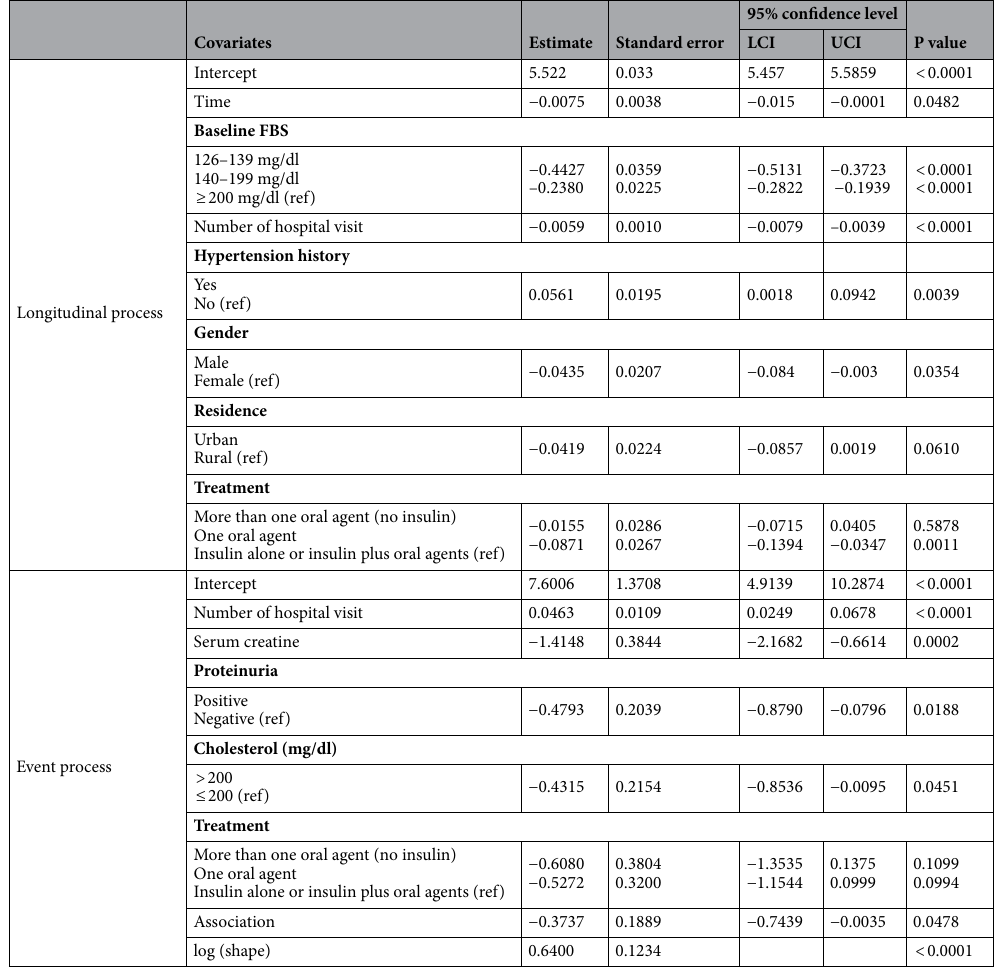
Table 4. Result of joint longitudinal and survival analysis on T2DM patients under anti type 2 diabetes drugs in FHRH, December 2011–March 2016. Formula calculating change in FBS for longitudinal process = ( e -1), formula calculating adjusted hazard ratio for event process = e